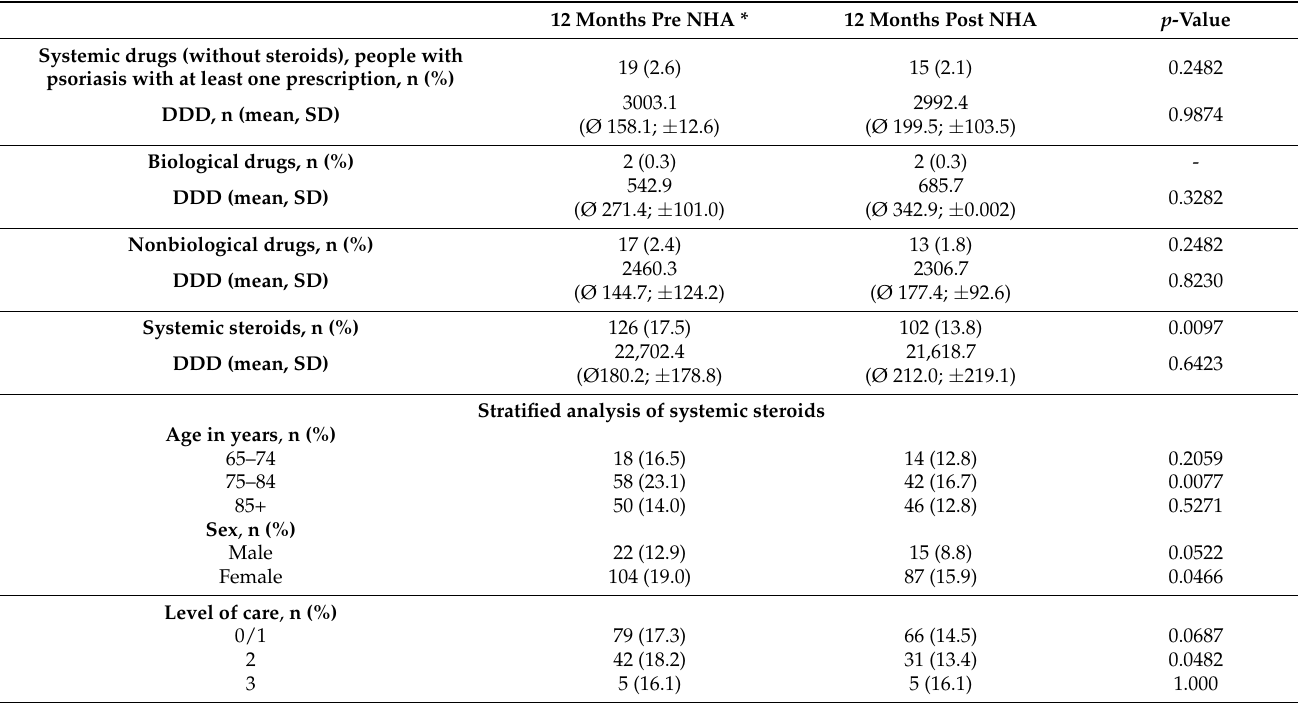
Table 8. Systemic therapies in insured people with psoriasis before and after NHA (N = 718). 12 Months Pre NHA * 12 Months Post NHA p